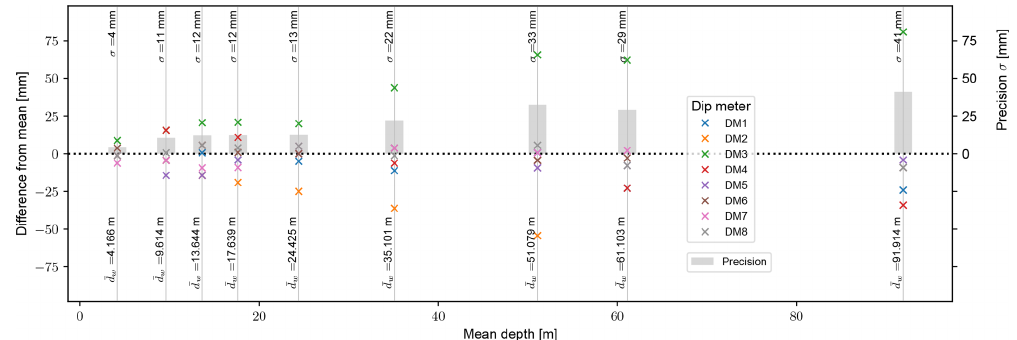
Figure 4. Manual measurement of nine different groundwater depths using eight different dip meters: difference from mean and standard deviation (precision) over mean